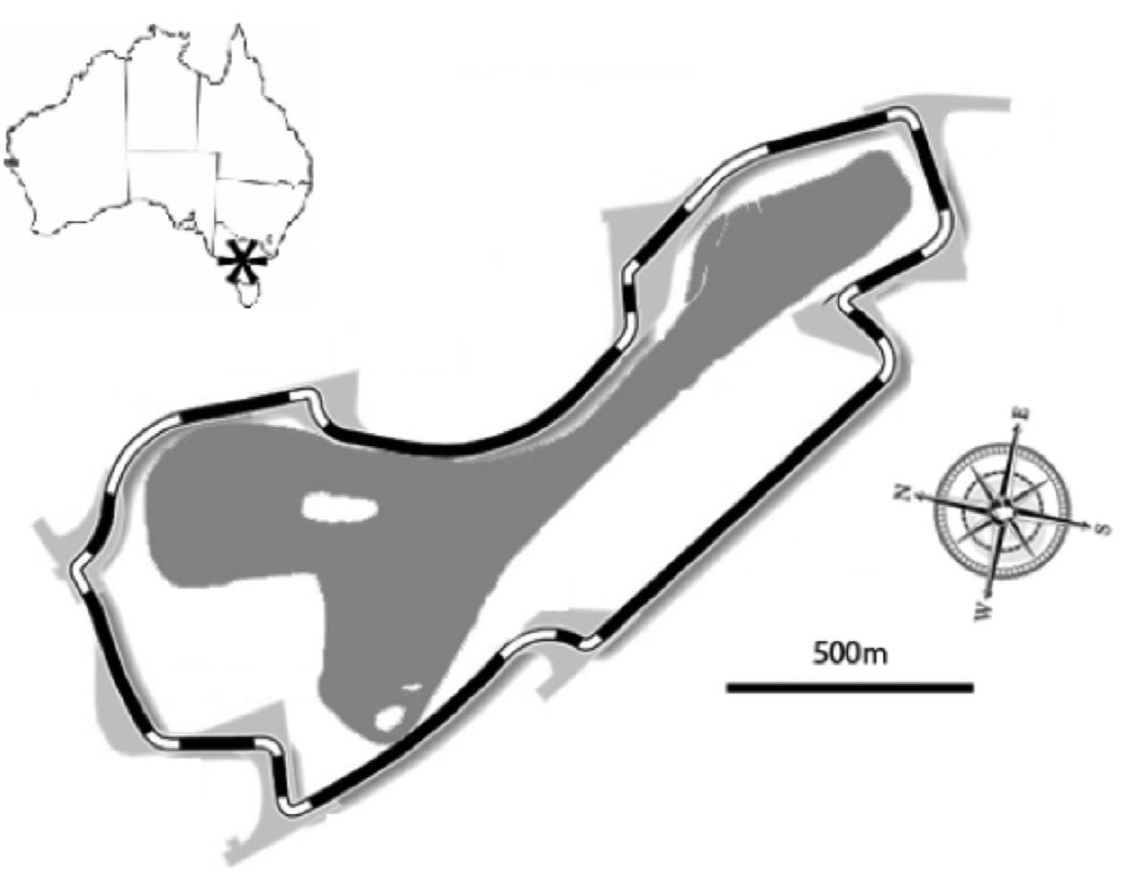
Figure 1. Map of the Grand Prix circuit, illustrating the location of the lake water body (grey) in relation to the racetrack (alternating black and white). Asterisk on the map of Australia depicts the location of Melbourne.